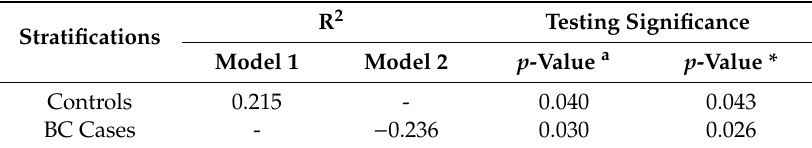
Table 4. Correlation analyses between plasma 25(OH)D and DNA repair capacity levels in women with and without breast